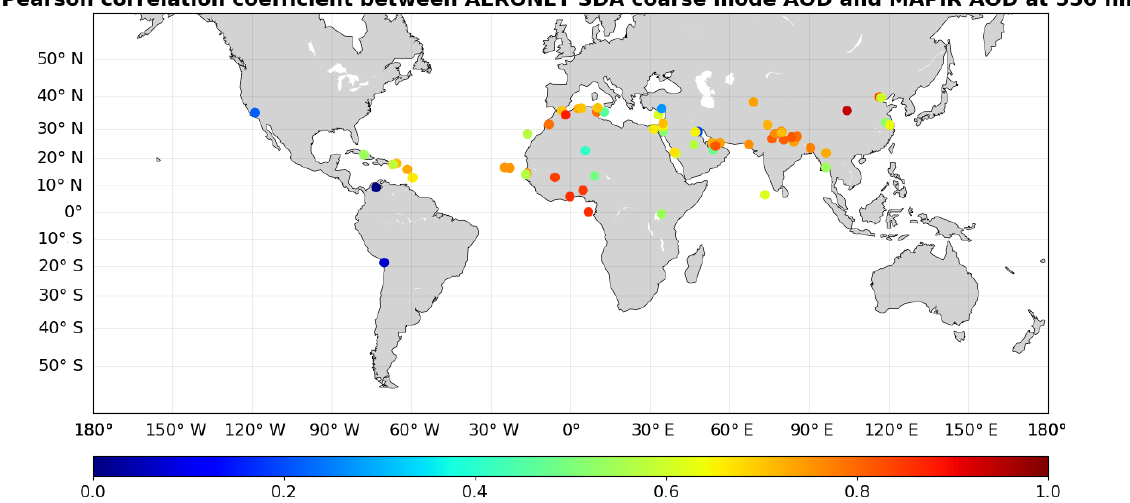
Figure 5. Map of the 72 AERONET stations that were matched with IASI measurements. The color scale represents the value of the Pearson correlation coefficient between the AERONET SDA coarse-mode AOD and the MAPIR AOD converted to